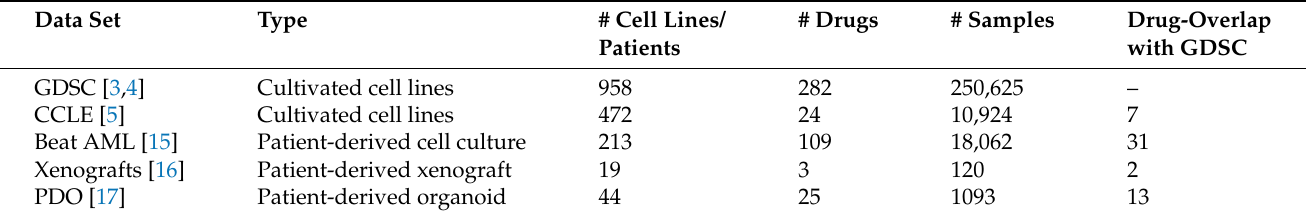
Table 1. Statistics of used data